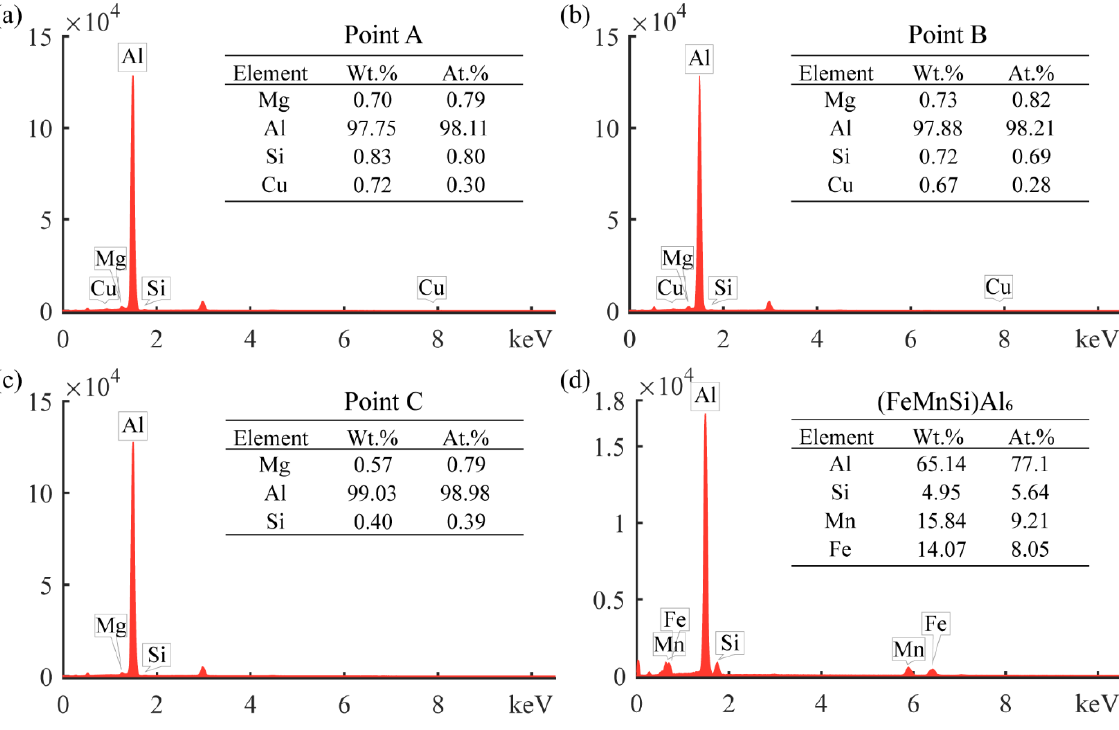
Figure 6. EDS results in different areas: ( a ) cell wall, ( b ) metallurgical composite layer, ( c ) panel, ( d ) white phase in the panel.